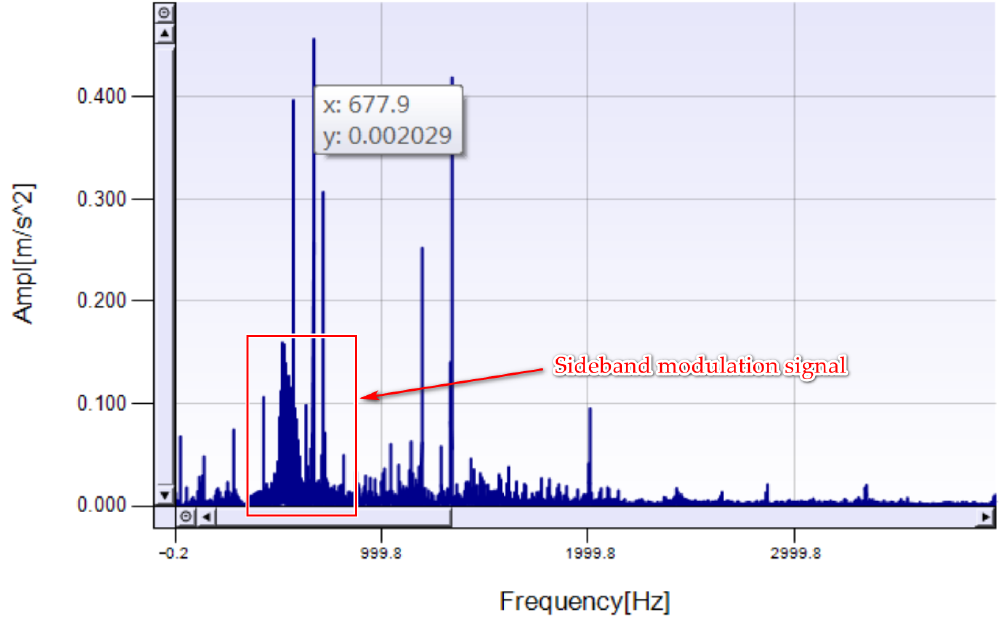
Figure 13. Frequency spectrum of the vibration signal of the medium speed-shaft position in gearbox of wind turbine A under warning conditions.